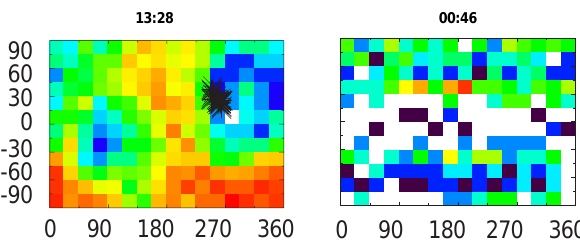
similar to Cluster, ISEE was crossing the dayside magne- topause in a nearly orthogonal fashion.